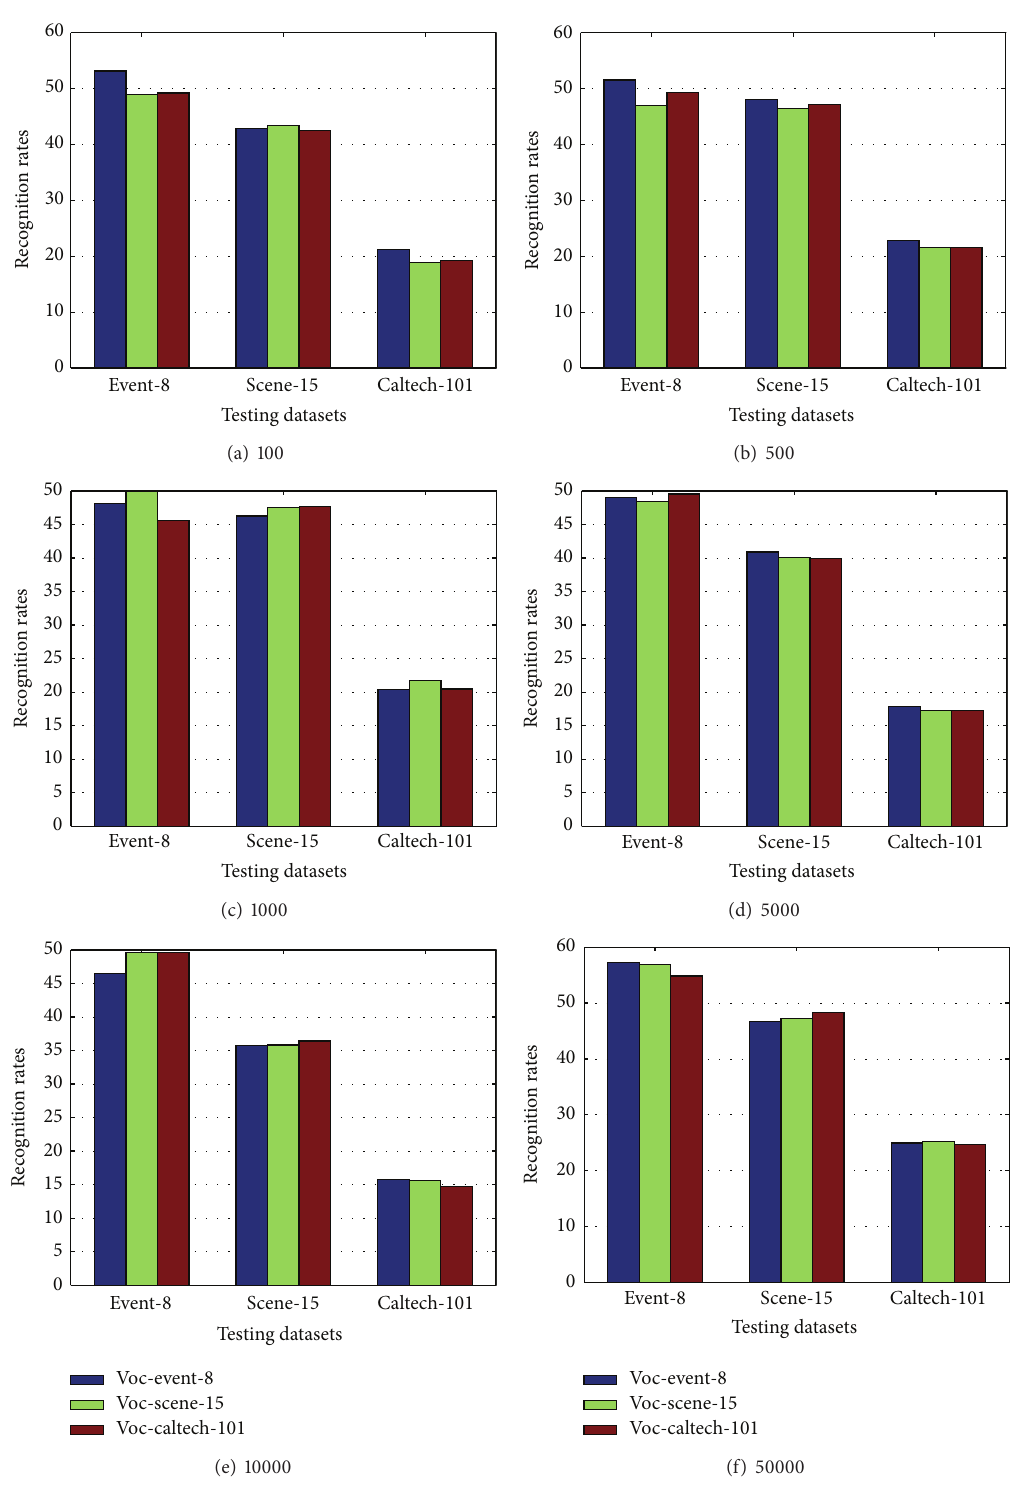
Figure 2: The relationship between universality of the algorithm and vocabulary sizes, with 𝑘